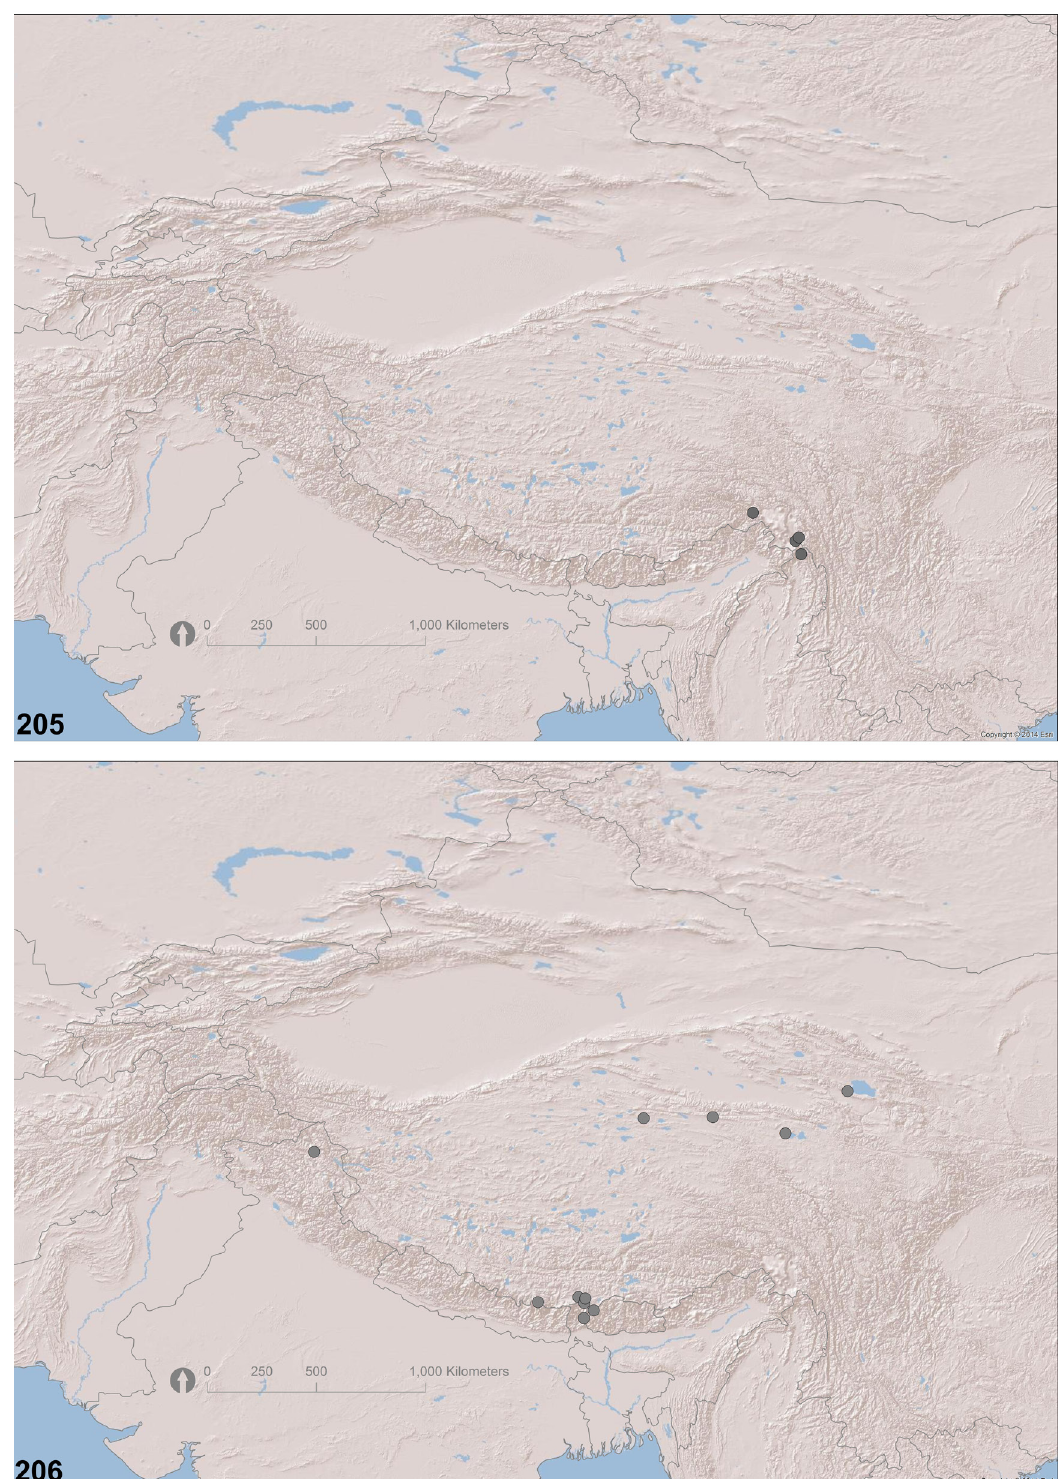
Figs 205–206. Maps of all available global records with all of the specimens examined and confirmed here. 205 . Bombus richardsiellus (Tkalců, 1968). 206 . B. tanguticus Morawitz, 1887. Relief map with hill shading for the region centred on Tibet with (grey lines) borders to national administration as in UN maps. Image created in ArcGIS using World_Shaded_Relief basemap © 2014